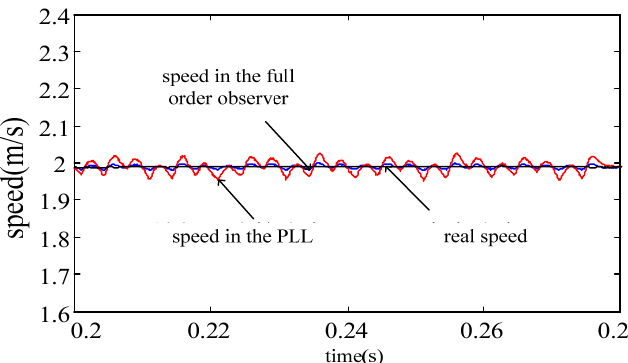
Figure 8. Estimated position by the different back - EMF. ( a ) Actual position and estimated position; ( b ) position error.